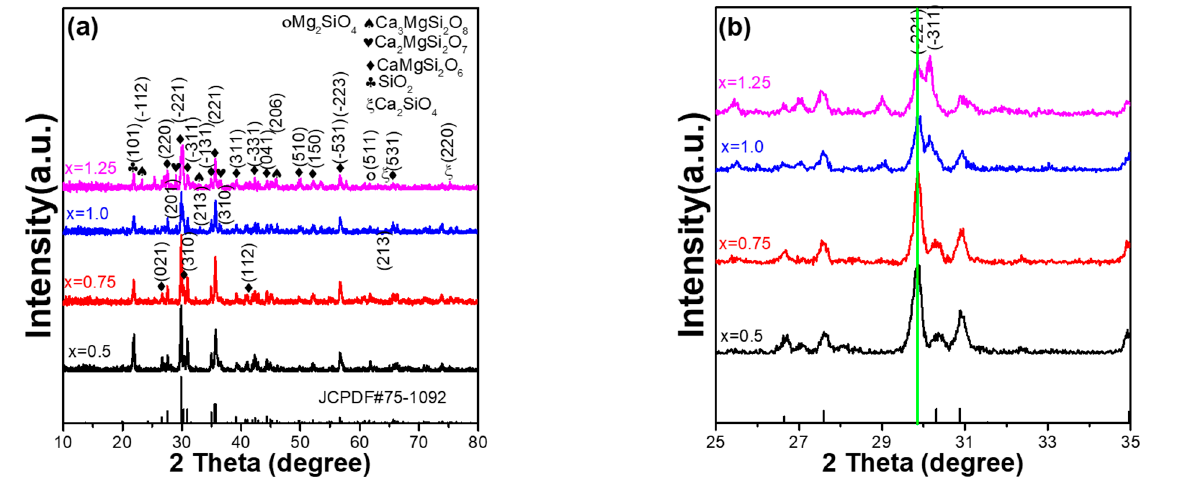
Figure 2. XRD patterns of Ca x Mg 2-x Si 2 O 6 :0.025Eu 2+ phosphors as a function of Ca content and the XRD pattern of standard JCPDS No. 75-1092: ( a ) in a large range, and ( b ) in a narrow